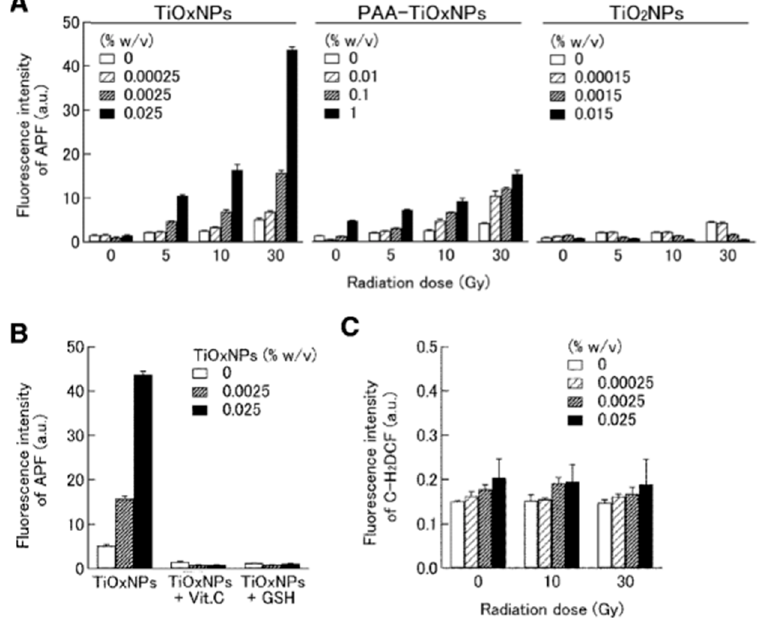
Figure 24. ROS production by the TiOxNPs, PAA-TiOxNPs, and TiO 2 NPs under X-ray irradiation. ( A ) Atomic packing factor (APF) intensity indicating that hydroxyl radical production in the TiOxNPs and the PAA-TiOxNPs increased in a radiation dose-dependent manner, but that of the TiO 2 NPs did not. Irradiated radiation doses were 0, 5, 10, and 30 Gy. Data are shown as the mean ± SD from 5 independent experiments. ( B ) Production and scavenging of ROS by 1 mM vitamin C (Vit. C) or 1 mM glutathione (GSH). Histograms show the mean ± SD calculated from 5 independent experiments. ( C ) Hydrogen peroxide production from the TiOxNPs under X-ray irradiation [149]. Copyright 2016 Springer Nature Switzerland